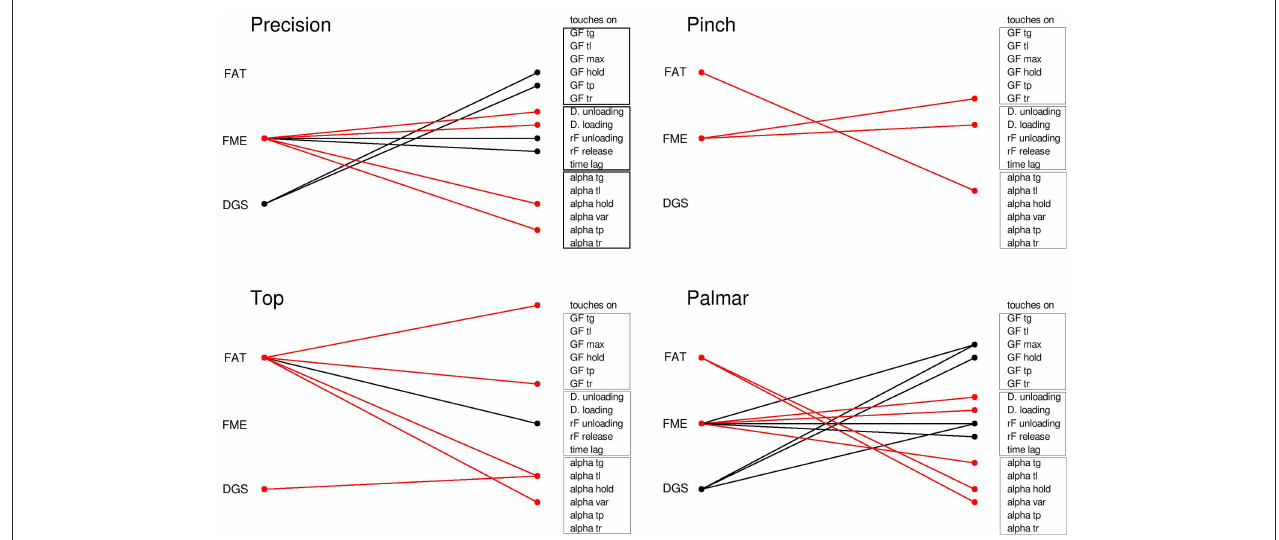
FIGURE 9 | Correlation between clinical data and behavioral variables for the different grasp types. Lines represent significant Spearman correlations (positive in black, negative in red) between clinical measures and iBox variables. FAT, Frenchay arm test; FME, Fugl Meyer Evaluation; DGS, dynamometer grip strength; Touches on, frequency of touches before tg ; GF, grip force at different time points; D, phase duration; Time lag, time difference between maximal grip force and peak acceleration during lifting; Alpha, deviation of the iBox from the vertical at the different time points; Alpha var, variability of alpha angle during